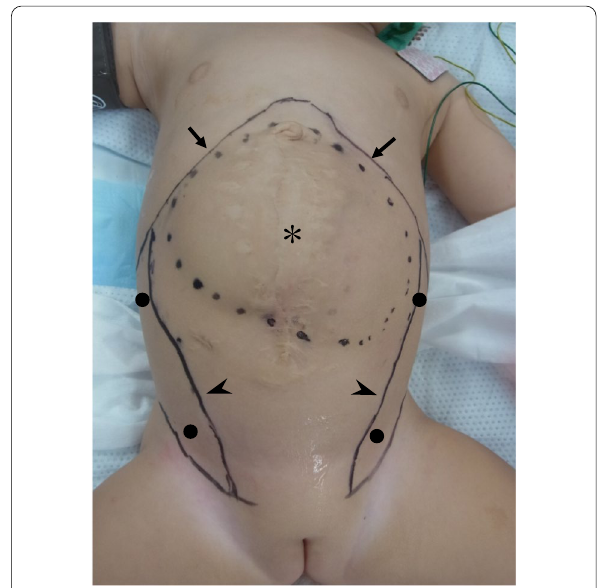
Fig. 1 Preoperative appearance of the patient with protruded liver covered by the skin only ( ∗ ). The inferior edges of the rib are marked by arrows ( ), and the lateral edges of the rectus muscles → are marked by arrowheads ( ➤ ). Port sites ( ● ) are at subcostal and inguinal regions on both